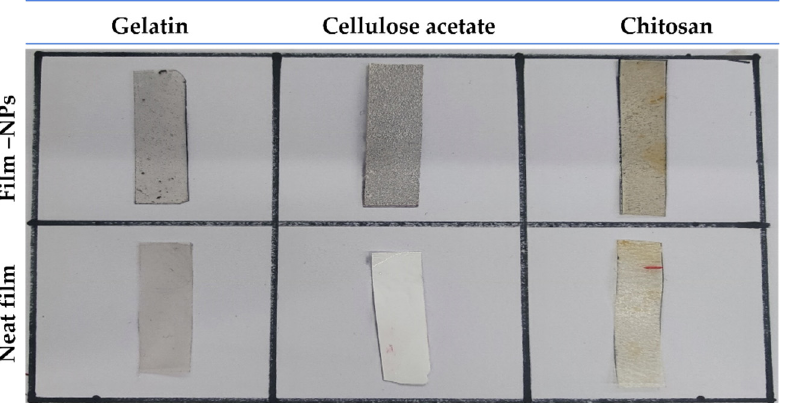
Figure 4. Photographs of the different films (gelatin-based, cellulose acetate-based, and chitosan- based composite films) with Fe x O y (1.0% w / w ). Neat films (gelatin-based, cellulose acetate-based, and chitosan-based films) without Fe x O y nanoparticles incorporated were included as references.